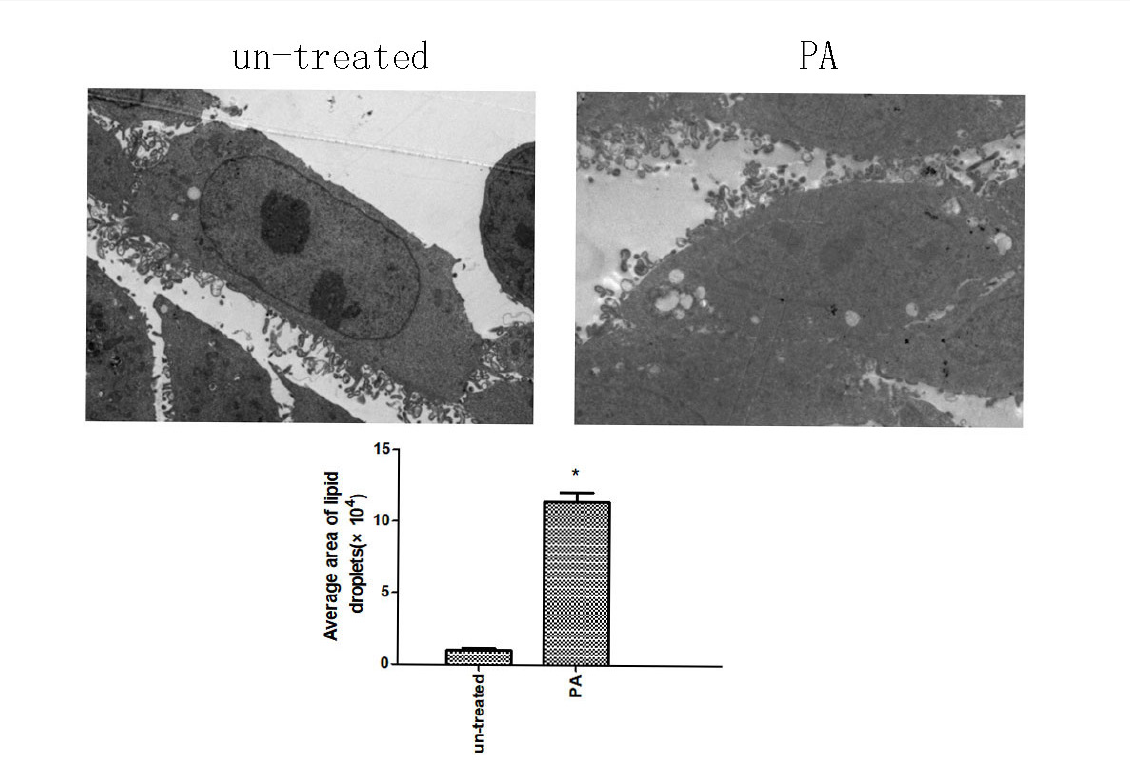
FIGURE 2 - Lipid droplets of HepG2 cells after 24 h induction with